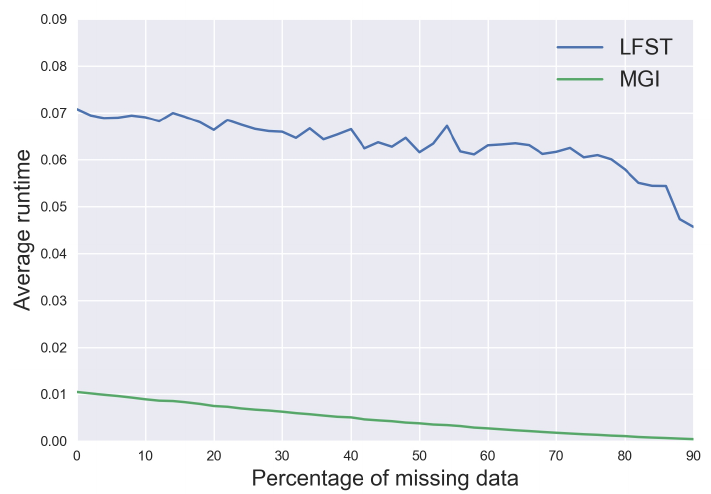
Figure 15. Comparison of the average runtime in CubeWorld (in